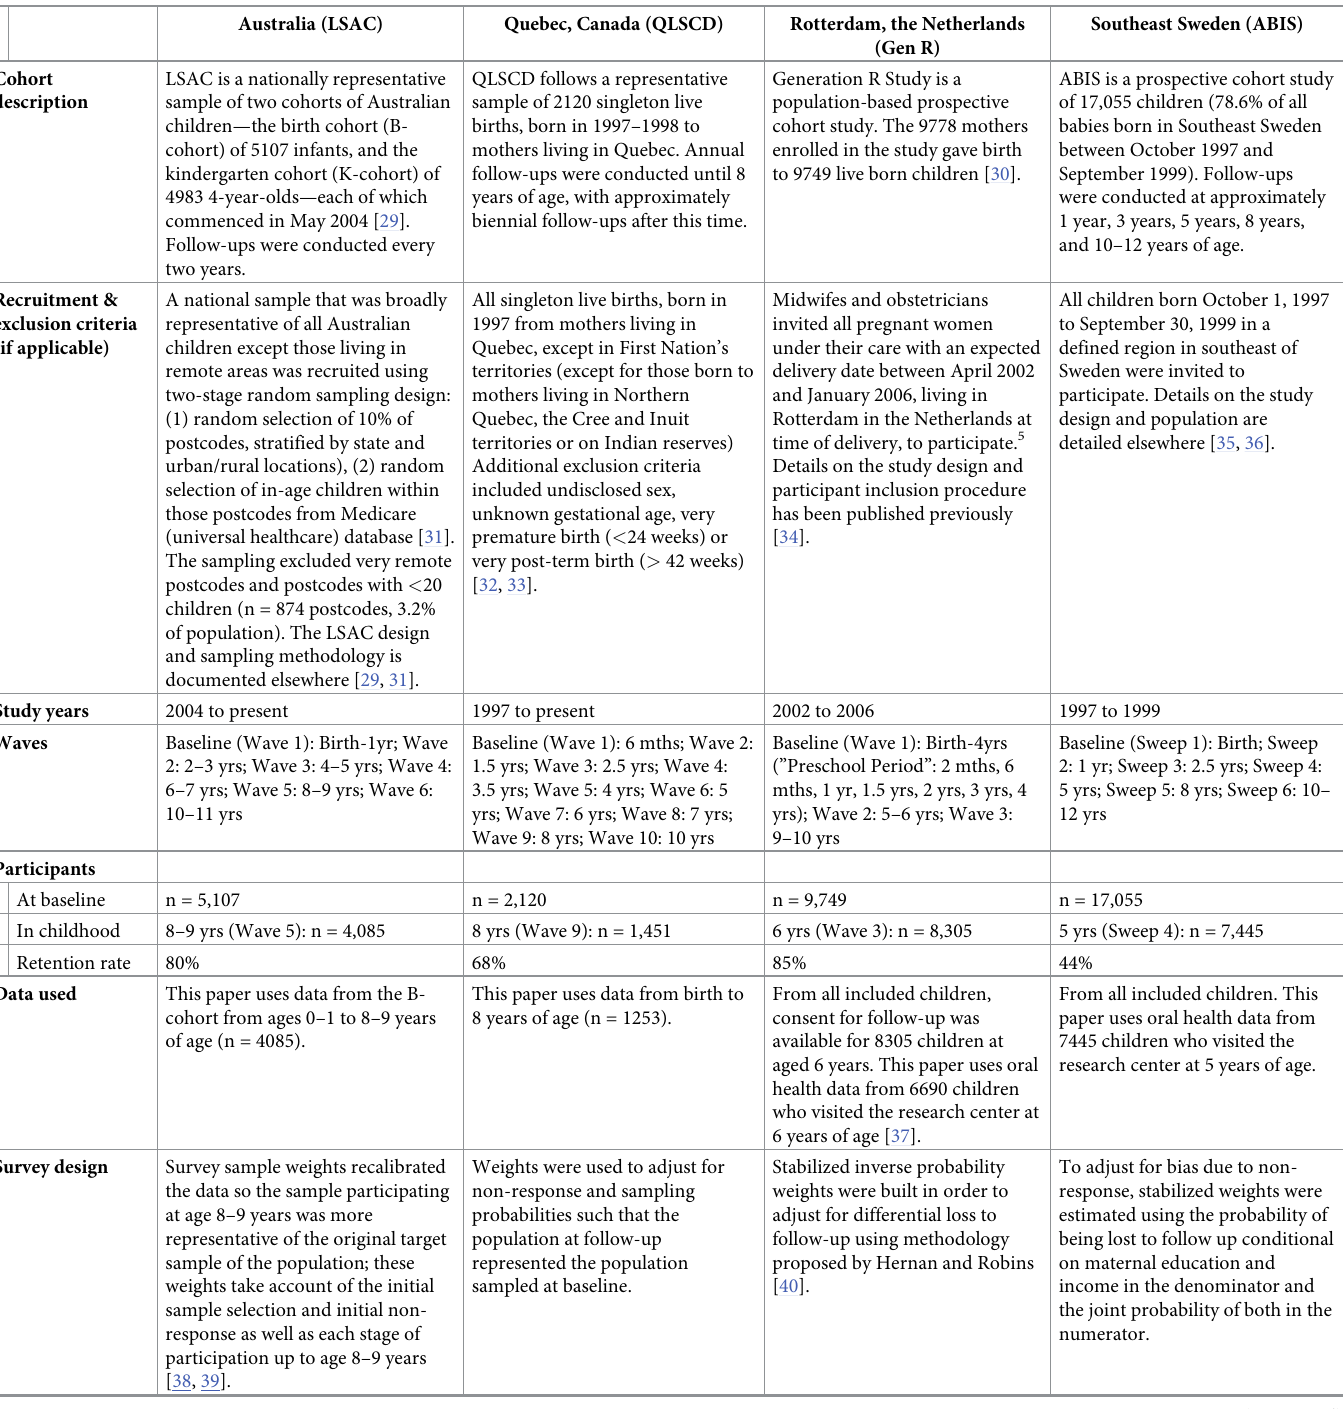
Table 1. Cohort descriptions and variable